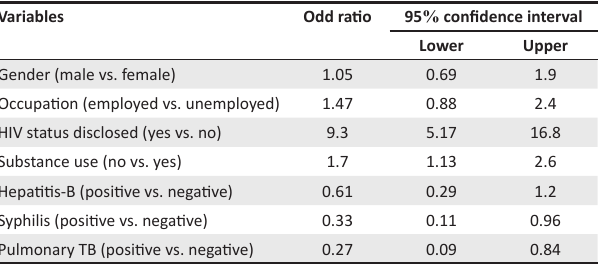
TABLE 5: Bivariate association between substance use and antiretroviral treatment adherence. Variables